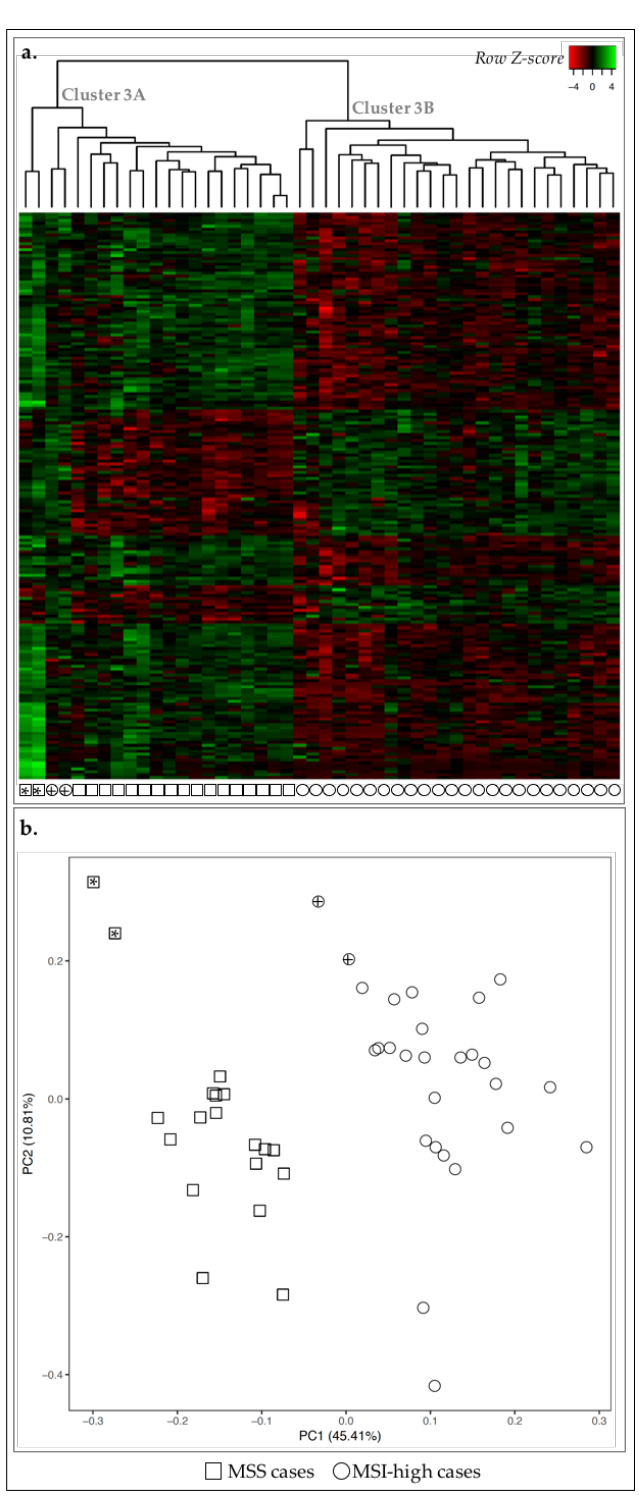
Figure 3. Expression profile of the 46 GC cases for 193 DE-genes between MSS and MSI-high cases. Asterisks and crosses are used for cross-reference between the two figures and as links to the main text. ( a ) Heatmap for the expression of the 193 DE-genes (log 2 and Z -score scaled). Indicated are two main clusters: 3A and 3B. ( b ) PCA for principal components 1 and 2 for the 46 GC samples. Squares correspond to MSS cases ( n = 19) and circles to MSI-high ( n = 27). Circles with cross or squares with asterisk for correspondence between panels ( a ) and ( b ) and described in the main text.